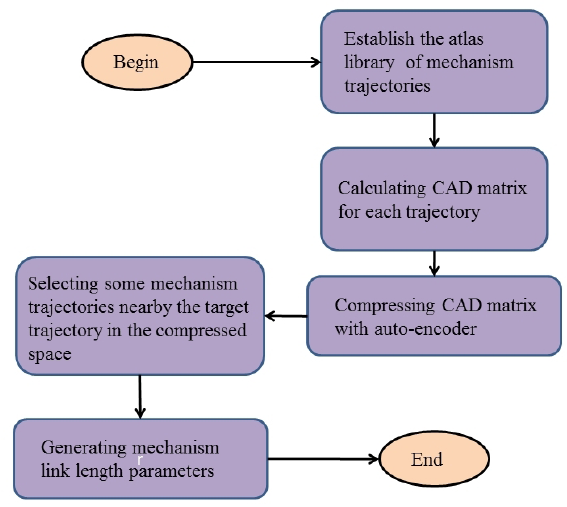
Figure 11. Flowchart of the design